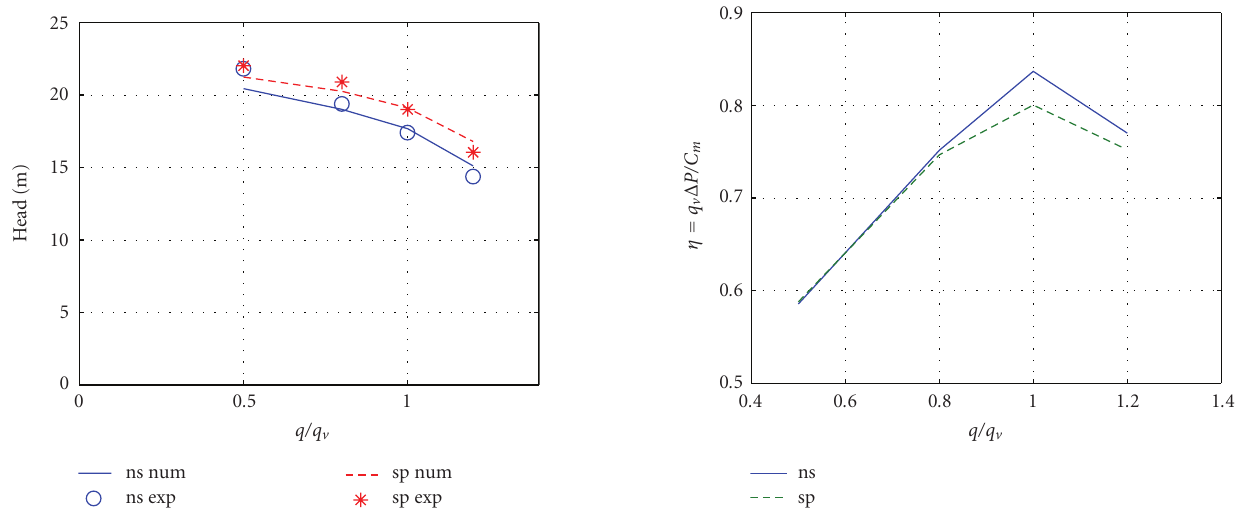
Figure 7: Head against flow rate (0 . 5 q bep , 0.8 q bep , q bep , and 1 . 2 q bep ), N = 900 rpm, (a) comparison with test; (b) mechanical e ffi ciency. ns = nonsplittered, sp =